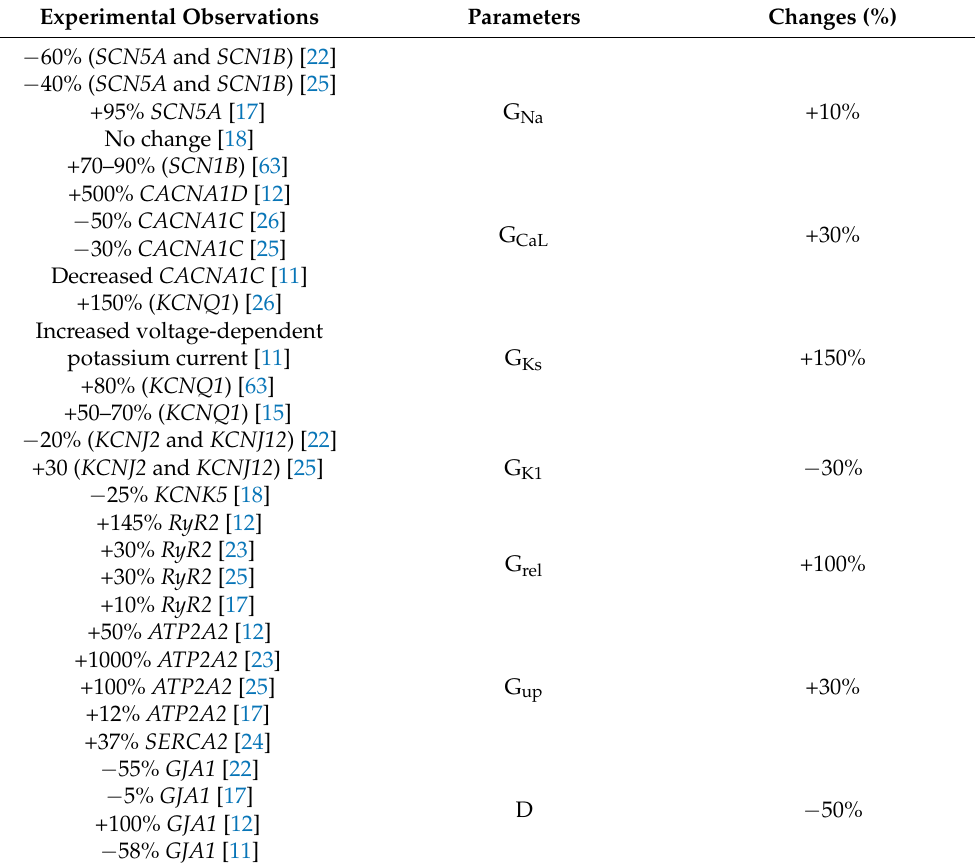
Table 3. Parameters associated with Pitx2 -induced remodelling.